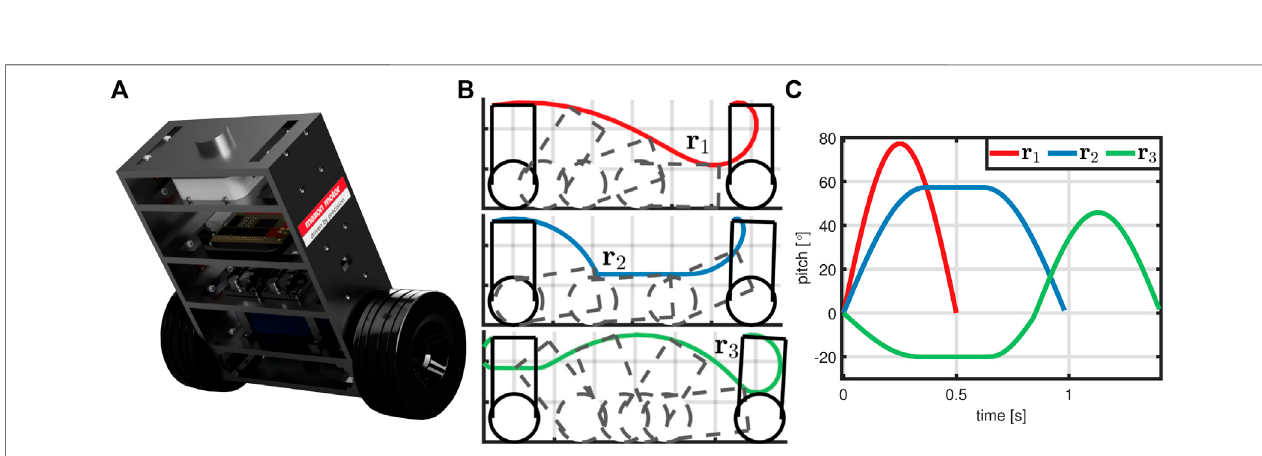
FIGURE5| Thelearningproblem:ATWIPR (A) ismeanttoperformthreechallengingmaneuvers (B) .Thecorresponding pitchangle references (C) differinlength, amplitude, and frequencies.